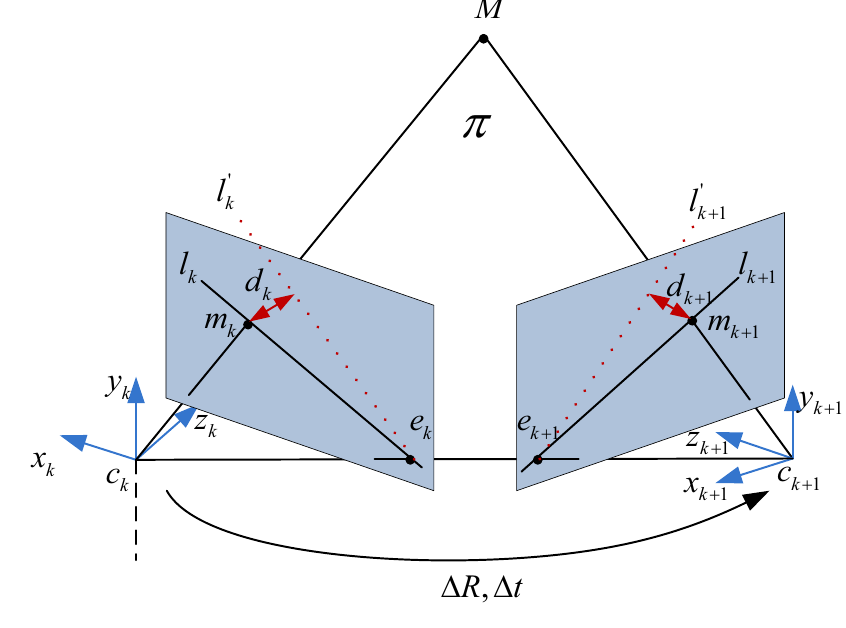
Figure 6. Epipolar